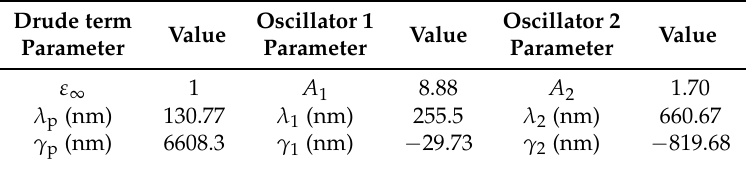
Table 1. Parameters of dielectric function of Au